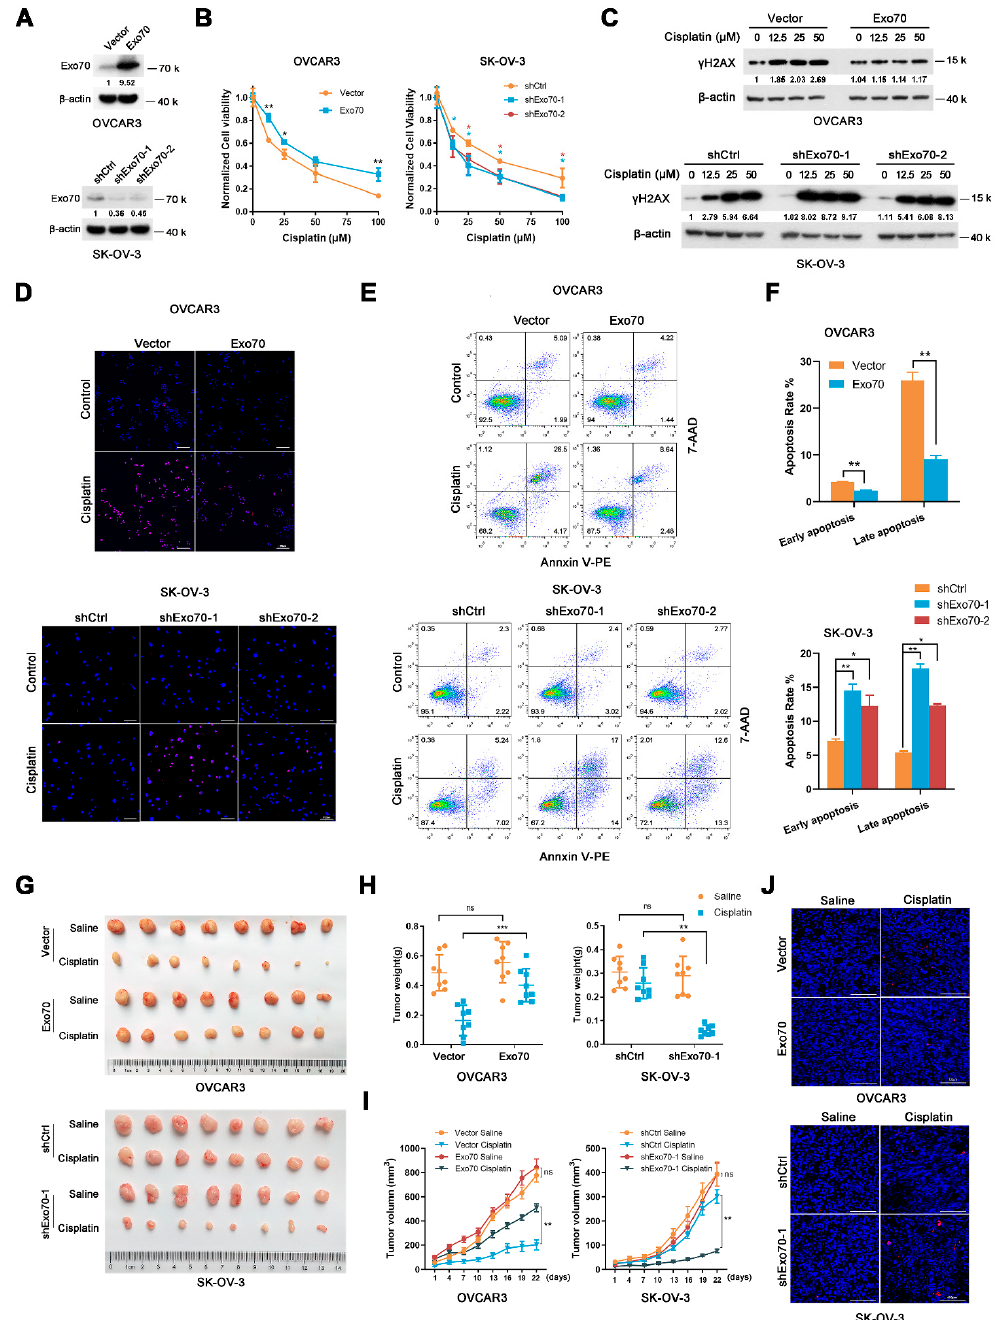
Figure 2. Exo70 affects cisplatin sensitivity of EOC in vitro and in vivo. ( A ) Western blotting showed the overexpression of Exo70 in OVCAR3 cells and the knockdown of Exo70 by shRNA in SK-OV-3 cells. ( B ) CCK8 assay examined the cytotoxicity of cisplatin in OVCAR3 cells (left panel) and SK-OV-3 cells (right panel). * p < 0.05, ** p < 0.01. ( C ) Western blotting showed γ H2AX expression level in OVCAR3 cells or SK-OV-3 cells after 24 h treatment with cisplatin. ( D ) Representative images of TUNEL staining for OVCAR3 cells or SK-OV-3 cells. Cells were treated with 50 µ M cisplatin for 3 h. Scale bar, 100 µ m. ( E ) Representative images of FACS analysis by Annexin V and 7-AAD double staining. ( F ) Percentage of apoptotic cells as detected by FACS analysis. Data were expressed as mean ± SEM, n = 3. * p < 0.05, ** p < 0.01 ( G ) Pictures of OVCAR3 or SK-OV-3 cells’ xenograft tumors in nude mice treated with or without cisplatin. ( H ) Tumor weights of mice with or without cisplatin treatment. Data were expressed as mean ± SEM, n = 8. ns: not significant, ** p < 0.01, *** p < 0.001 ( I ) Growth curve of tumor volume in mice with or without cisplatin treatment. Data were expressed as mean ± SEM. ns: not significant, ** p < 0.01 ( J ) Representative images of TUNEL staining of tumors with or without cisplatin treatment. Scale bar, 100 µ